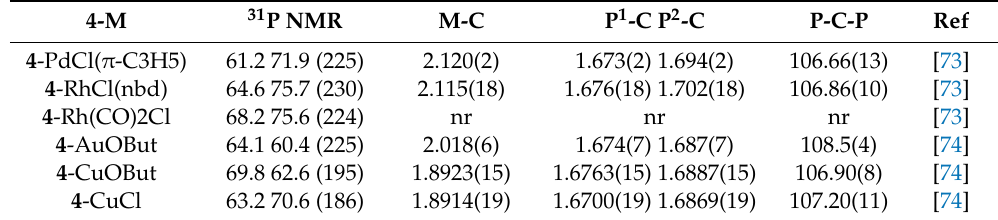
Figure 6. Structure of compound 4 . Table 4. Transition metal complexes with the cyclic carbone 4 , containing 31 P NMR shifts and relevant structural parameters.